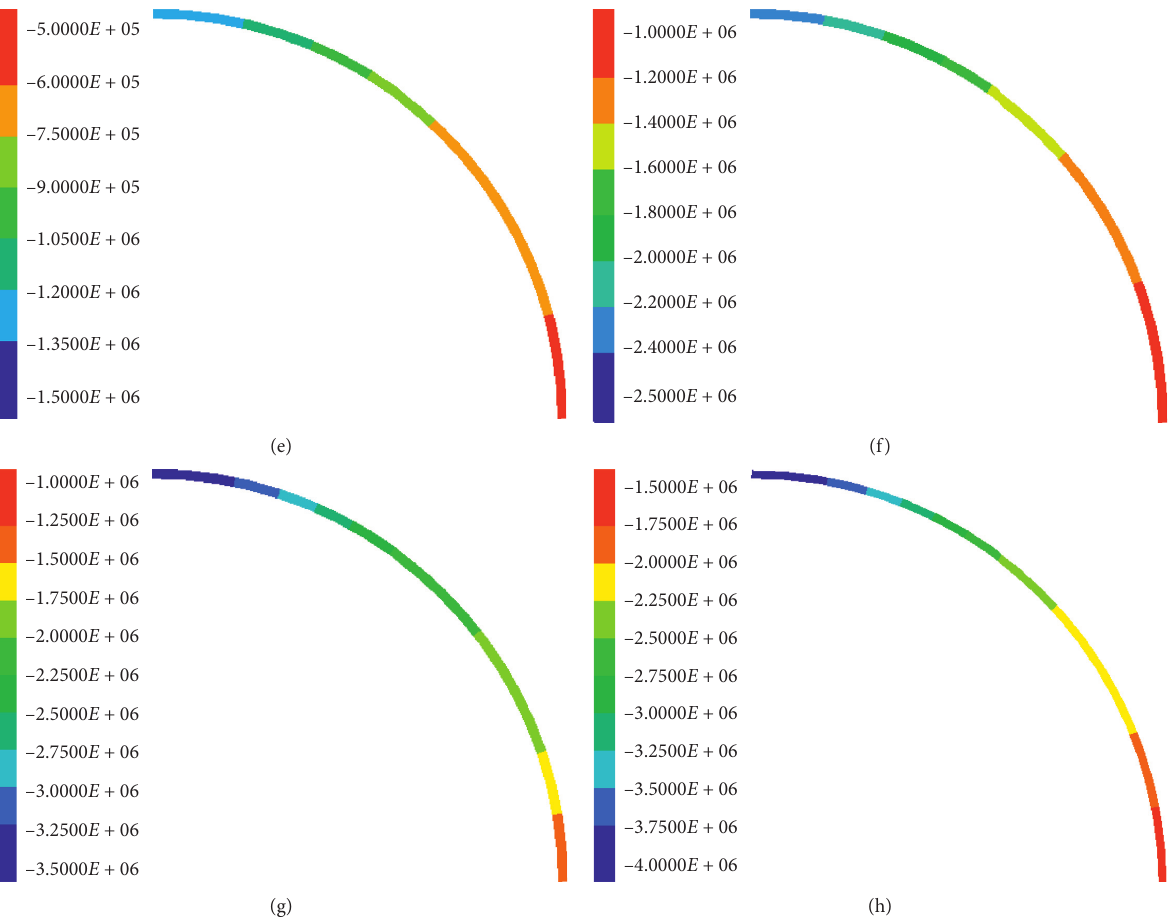
Figure 18: The contour map of maximum principal stress (a) ∼ (d) show the result of no BDZ, (e) ∼ (h) show the result of BDZ, corresponding to the section of 100m, 200m, 300m, and 400m, respectively (unit: Pa).